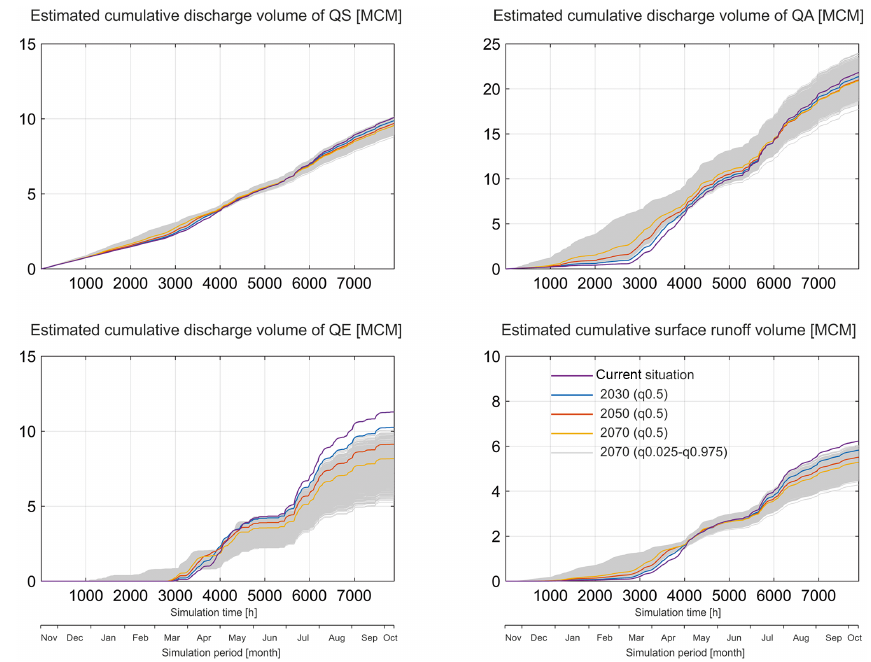
Figure 9. Impacts of the median climate scenarios ( q 0 . 5) for years 2030, 2050 and 2070 as well as the uncertain climate scenarios (1000 random sampled combinations) for 2070 on the simulated discharge of QS, QA, QE and surface runoff from the non-karst